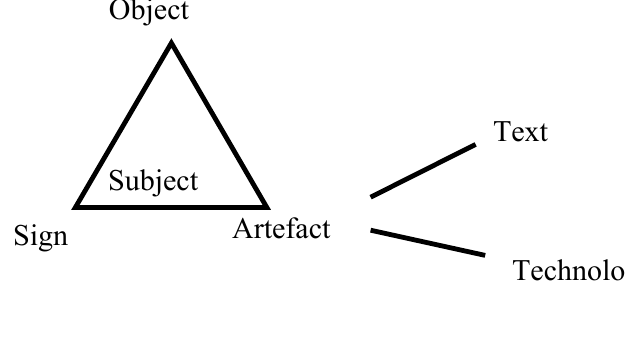
Figure 3 . Objects, signs and artefacts